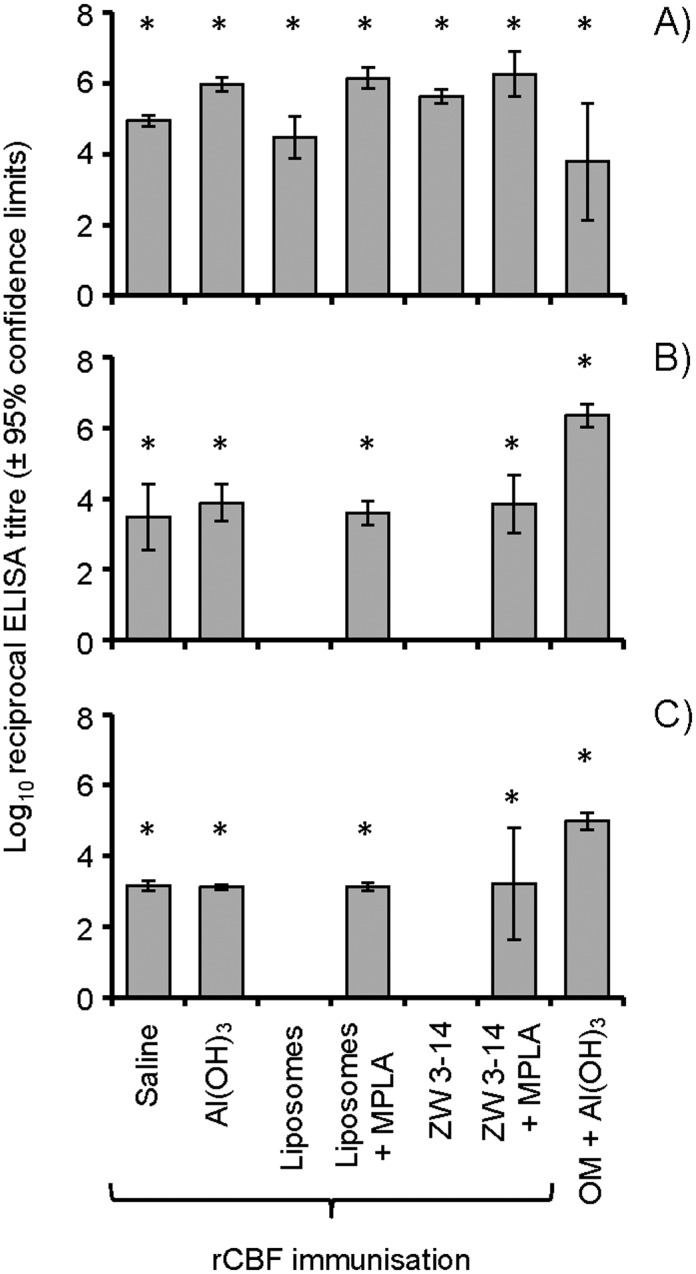
ELISA reactivity of antisera raised to different rCBF formulations against pure rCBF protein, outer membranes (OM) and whole meningococcal cells.Antisera from individual animals immunized with rCBF in various adjuvant and delivery formulations and from animals immunised with OM, were reacted in ELISA against A) purified rCBF protein, B) MC58 OM and C) whole MC58 meningococcal cells. The columns represent the geometric mean reciprocal ELISA titres (n = 4 or 5 animals per group) and the error bars represent the 95% confidence limits. No significant reactivity with rCBF, OM or whole cells in ELISA was observed with sera from sham-immunized animals or with normal mouse serum (absorbance values λ450nm <0.1 for serum dilutions of 1/10). The * denotes that the responses were statistically higher than the corresponding sham-immunized animals (p<0.05), using an independent t-Test to compare differences between the mean values.